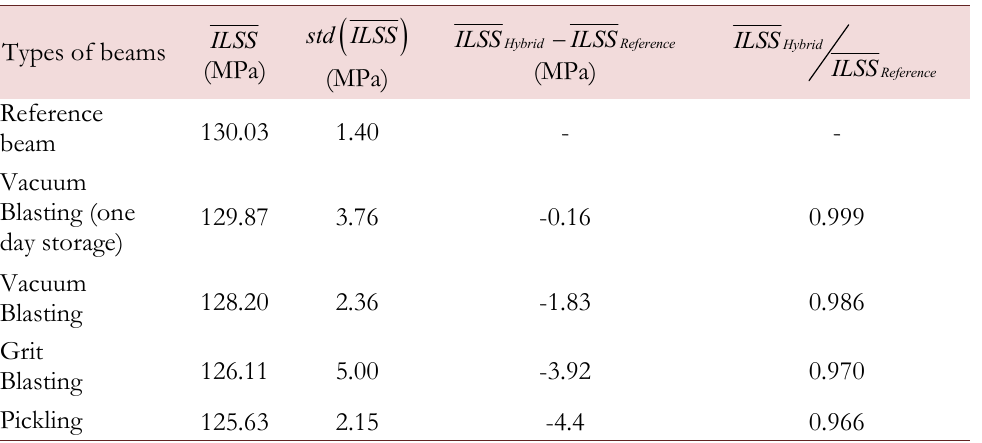
Table 3: ILSS Experimental results – Comparison between reference beam and the hybrid beams with different surface treatments.